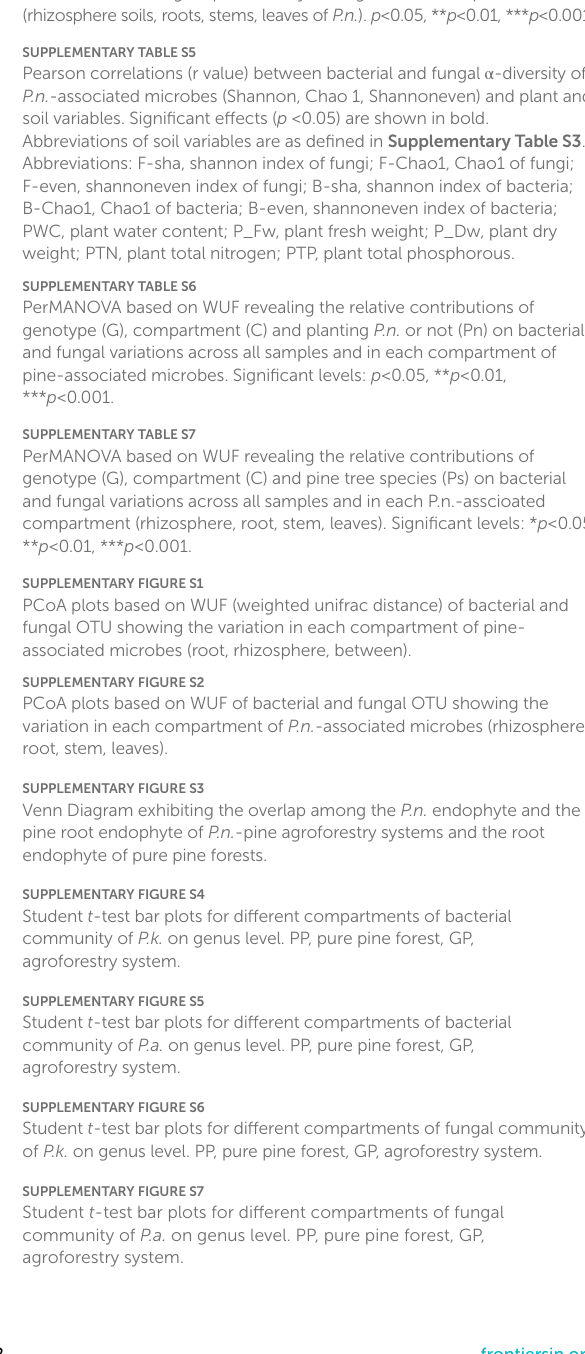
SUPPLEMENTARY TABLE S2 PerMANOVA (Permutational multivariate analysis) indicated the relative contributions of genotype (G), planting P.n. or not (Pn) and their interactions on bacterial and fungal alpha- diversity among different